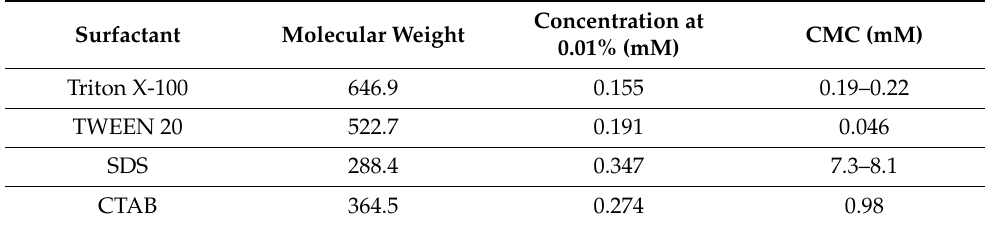
Table 2. Surfactant molecular weights, relevant molar concentrations at 0.01%, and critical micelle concentrations (CMC)